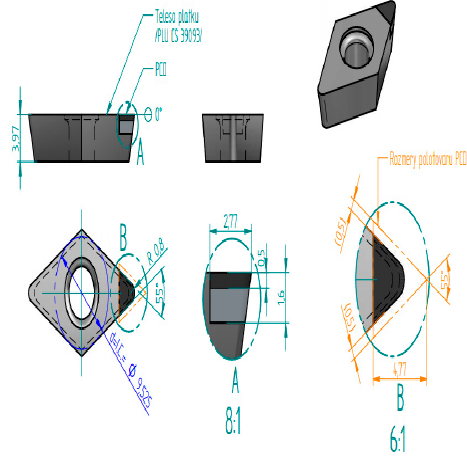
Figure 2. Cutting insert model DCGW 11T308.